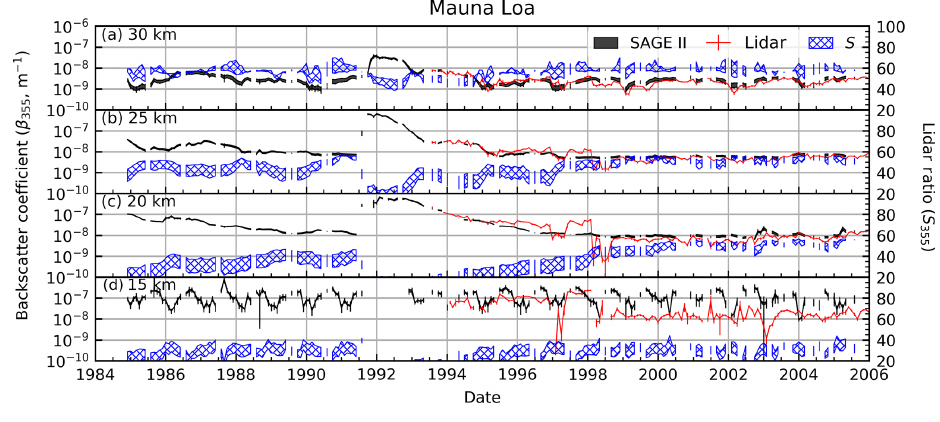
Figure 8. Same as Fig. 6, but for Mauna Loa. Table 2. Intercomparison statistics for the time series in Figs. 6, 7, and 8. The subscripts PE and BG indicate measurements impacted by the Pinatubo eruption (June 1991–December 1997) and background conditions, respectively. The line of best fit was calculated with SAGE as the independent variable. Values in parentheses under the %Diff columns indicate the standard error of the percent difference. Note: OHP has two products listed ( β and S , where S uses the conventional definition), hence the two